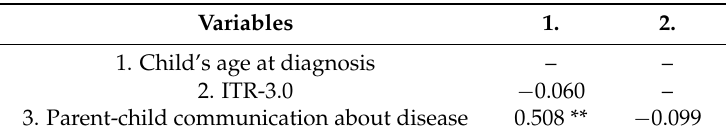
Table 4. Correlations of variables for multiple regression analyses.